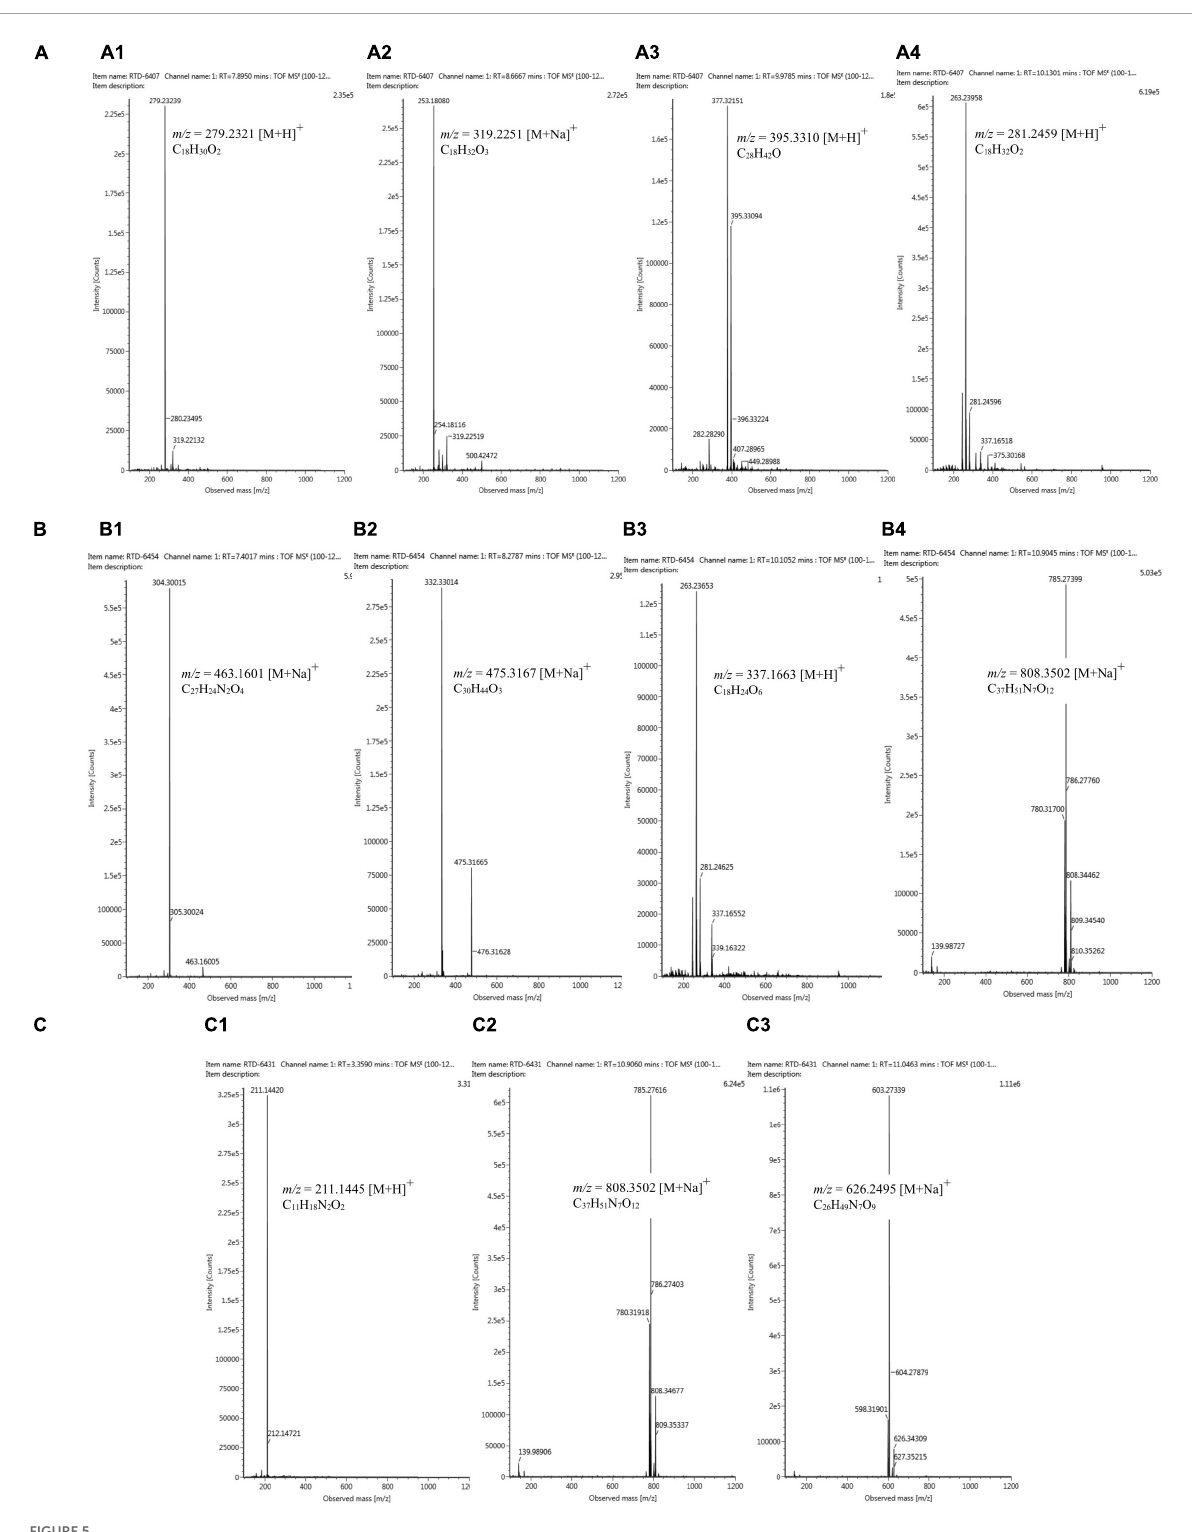
FIGURE5 Mass chromatogram of metabolite compounds from extracted isolates Trichoderma sp. 6407 (A1–4) , Phyllosticta sp. 6454 (B1–4) , and Neopestalotiopsis sp. (C1–3)